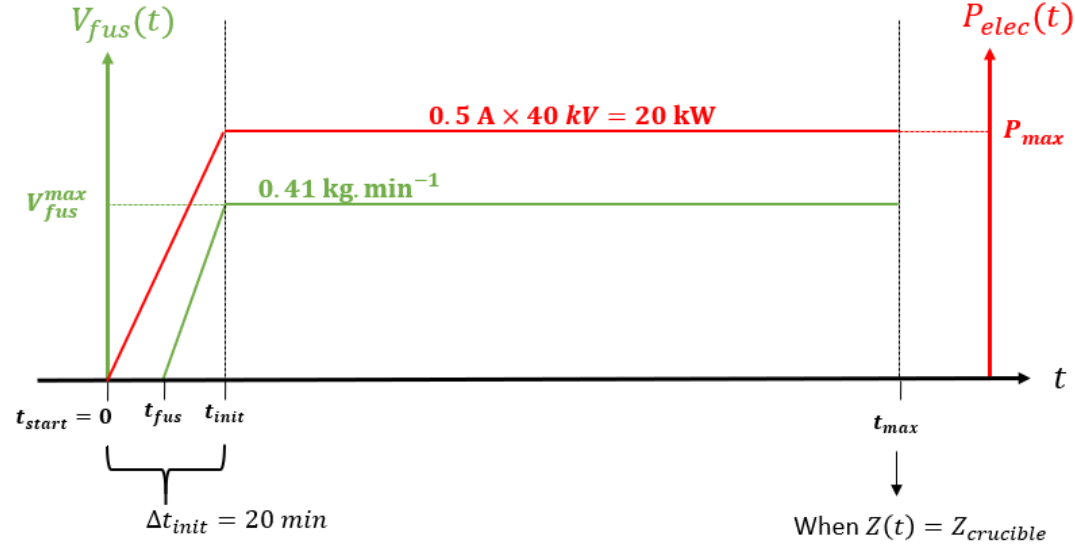
Figure 4. Experimental electrical power and melting rate versus time.